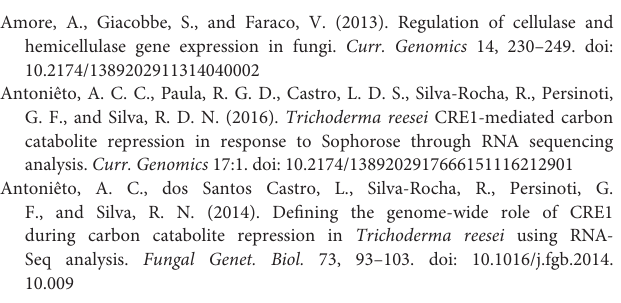
Figure S4 | Principal-components analysis (PCA) of samples analyzed. (A) Principal component analysis of the samples analysed for assessing overall similarity between the conditions using DESeq2’s plotPCA. (B) Sample QMGlu2 was removed from downstream analysis. Figure S5 | Box plot of all samples pre- and post-normalization. (A) Raw counts and (B) Normalized counts. Figure S6 | Differentially expressed genes (DEG) in ∆ xyr1 compared to parental strain QM9414 grown in cellulose, sophorose, and glucose as sole carbon sources. (A) ∆ xyr1 /QM9414 Cellulose, (B) ∆ xyr1 /QM9414 Sophorose, and (C) ∆ xyr1 /QM9414 Glucose. Differentially, expressed genes identified by DESeq2 package are plotted in red ( p ≤ 0.05 ). (D–F) Volcano plot of differentially expressed genes under all conditions studied. Log 2 fold changes and their corresponding − log 10 p -values of all genes in the RNA-seq are shown. Up-regulated genes (log 2 fold change ≥ 1 and p ≤ 0.05 ) are depicted in red and down regulated (log 2 fold change ≤ − 1 and p ≤ 0.05 ) in green. Figure S7 | Person correlation of estimated transcript levels measured by RNA-seq and qRT-PCR results. Comparison between gene expression values obtained by RNA-seq and qRT–PCR was performed using 20 genes ( Table S13 ). Real- time PCR was performed using the amplified cDNA from each RNA-seq sample. The solid line and R were generated by linear regression analysis using GraphPad Prism Version 5.0. A high and statistically significant Pearson correlation between the expression levels measured using real-time PCR and RNA-seq was obtained ( R = 0 .81, P < 0.0001 ). Conditions used for validation: cellulose and sophorose. Table S1 | qRT-PCR primers used in this study.